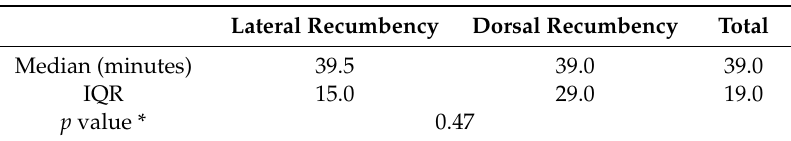
Table 6. Total surgical